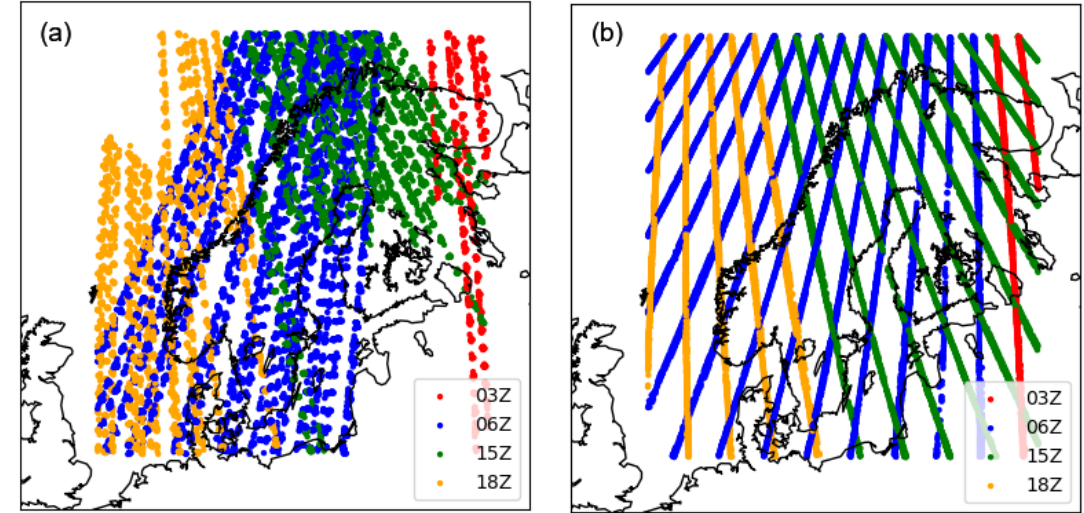
Figure 1. Available Aeolus overpasses during the experiment periods: 14 September to 14 October 2018 for laser A (a) and 20 April to 19 May 2020 for laser B (b) . The colour indicates the time of the